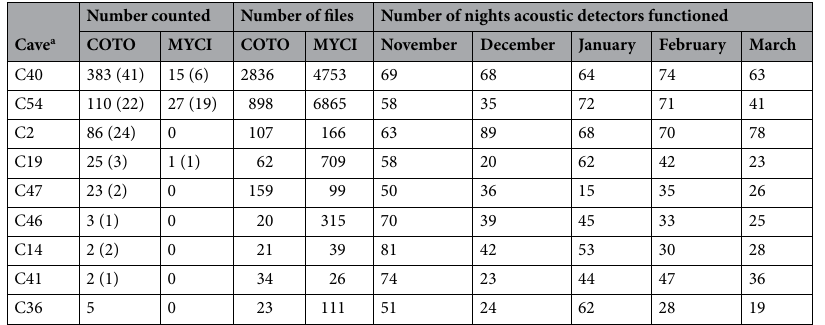
Table 1. Mean (± SD ) number of Townsend’s big-eared bats (COTO) and western small-footed myotis (MYCI) counted in hibernacula surveys in 9 caves across years we sampled with acoustic detectors, number of files of acoustic recordings for each species, and number of nights (sunset to sunrise) detectors functioned by month from 2011 to 2018 in southeastern Idaho, USA. All caves were collapsed lava-tube caves; except C14, C19, C36, and C41, which were lava blister caves. a Cave letter and numbers correspond with those in Whiting et al. 43